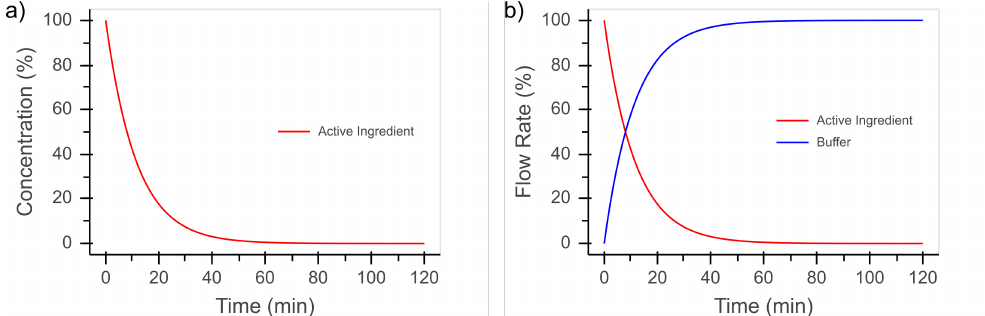
Figure 4. ( a ) Concentration profile according to Equation (1). ( b ) Deduced flow rates to mimic the concentration profile with two pumps, of which one contains the active-ingredient solution and the other contains a buffer